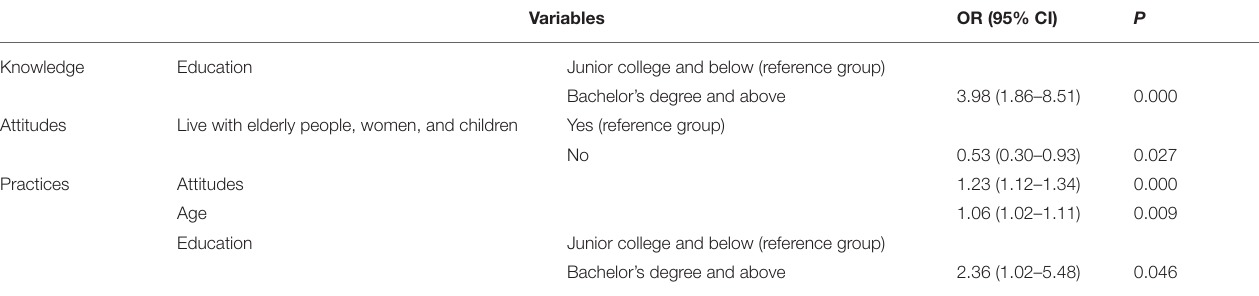
TABLE 5 | Binary logistic regression analysis on factors significantly associated with the knowledge, attitudes, and practices toward COVID-19 ( n =